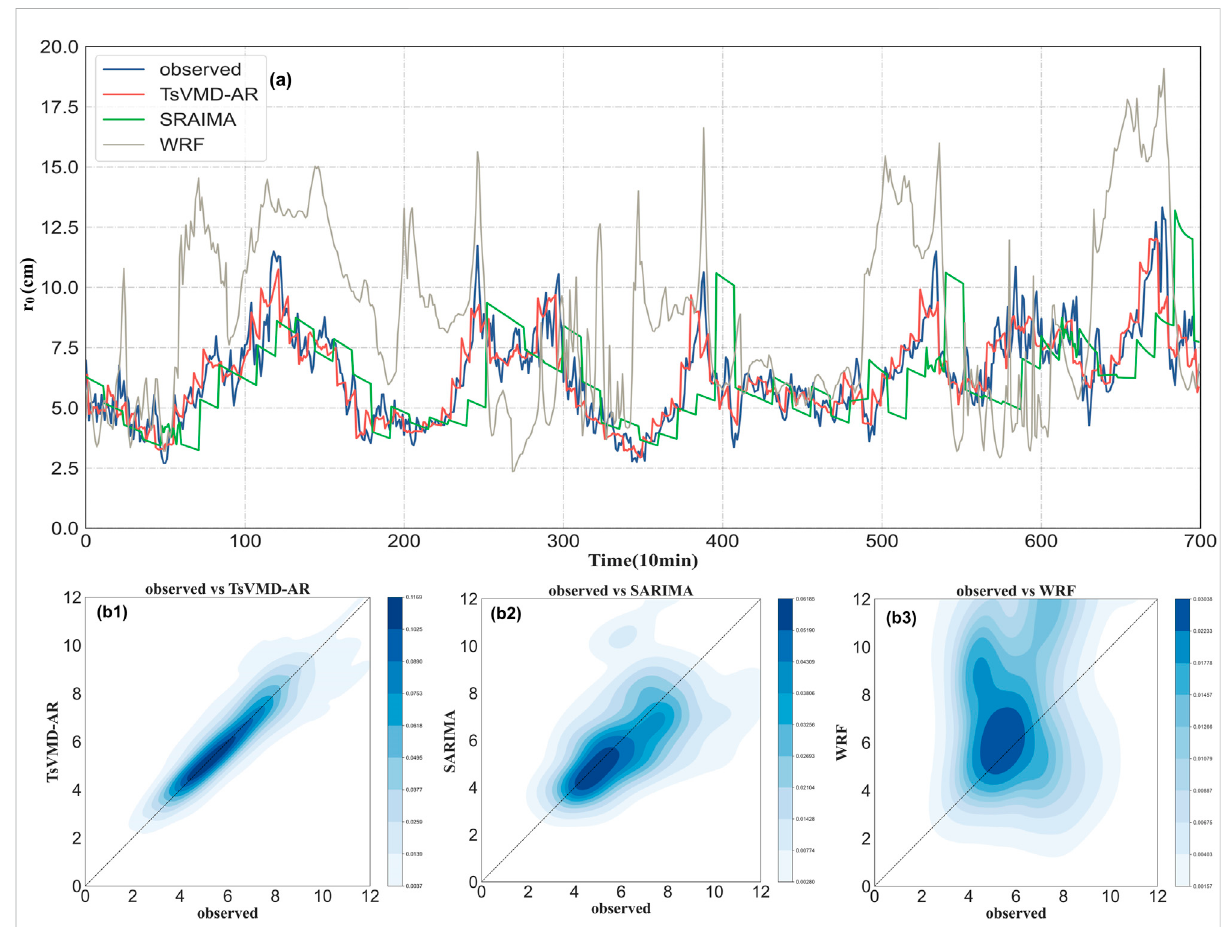
FIGURE 3 Forecasting results of the proposed method and the contrast method for period 1: (A) observed atmospheric turbulence (blue) and forecasting results of TsVMD-AR (red), SARIMA (green) and WRF (grey); 2D histograms of observed atmospheric turbulence verse forecasting results of TsVMD- AR (B1) , SARIMA (B2) and WRF (B3)